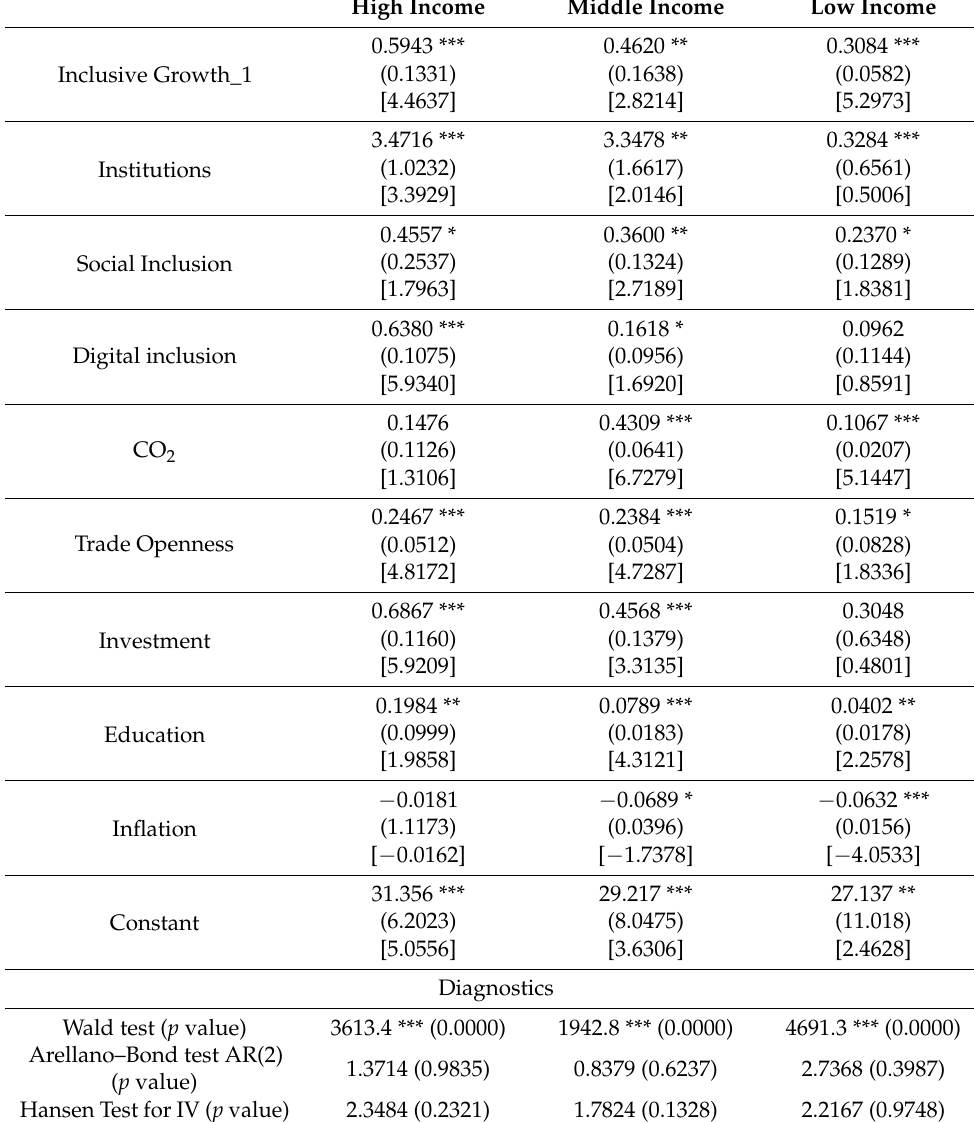
Table 1. Results for the impact of CO 2 on inclusive growth without interaction terms.